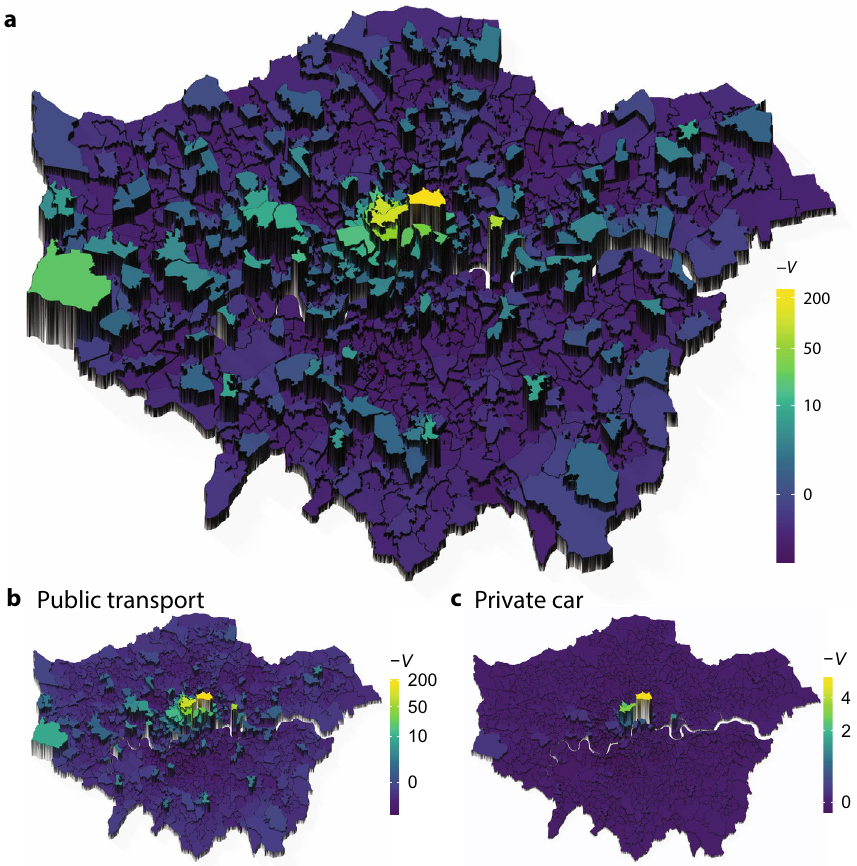
Figure 3. Negative potential − V of the home-work trips in London. ( a ) The potential at a place is indicated by its colour and its height. ( b,c ) The potentials are depicted for the selected trips by specific transport